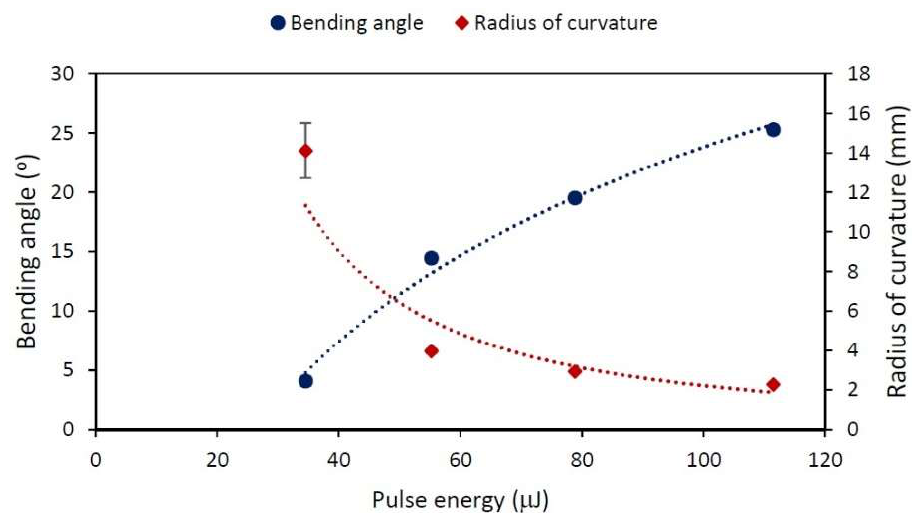
Figure 4. Bending angle (round points) and radius of curvature (diamonds) dependence on pulse energy ranging from 35 to 111 µ J. Treated area of 1 mm length, P y = 20 µ m, P x = 1 µ m, f = 1 kHz and v = 1 mm . The lines are visual guides.